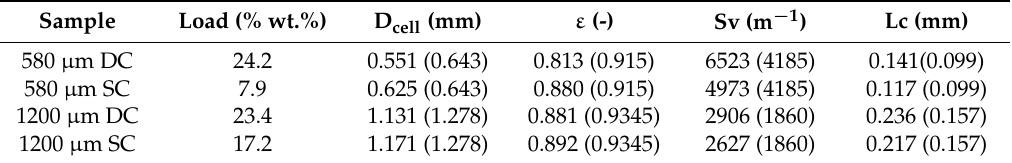
Table 2. Geometrical properties of tested samples, evaluated before (in brackets) and after coating deposition.